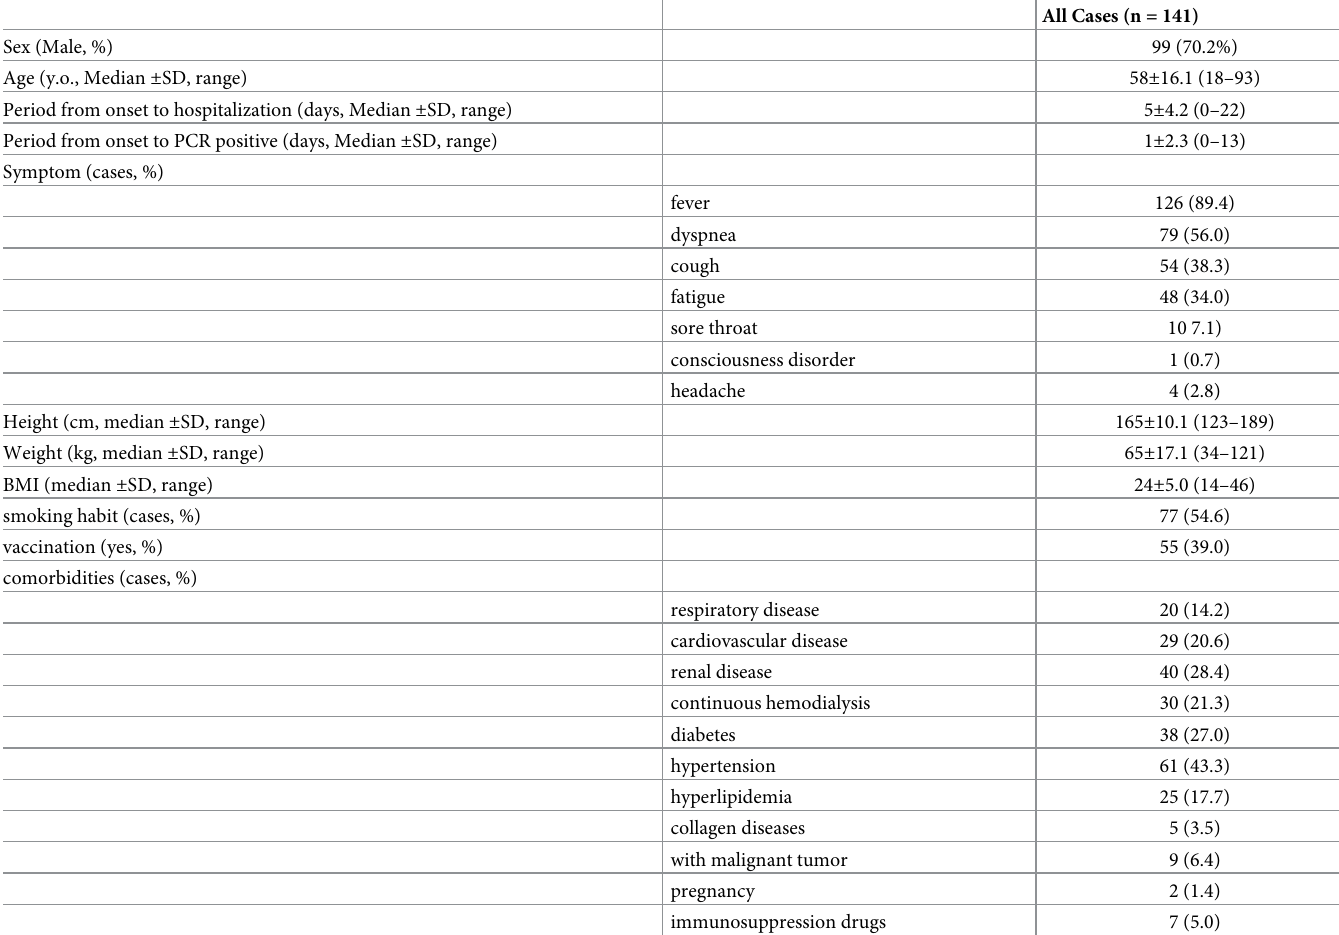
Table 2. Patients’